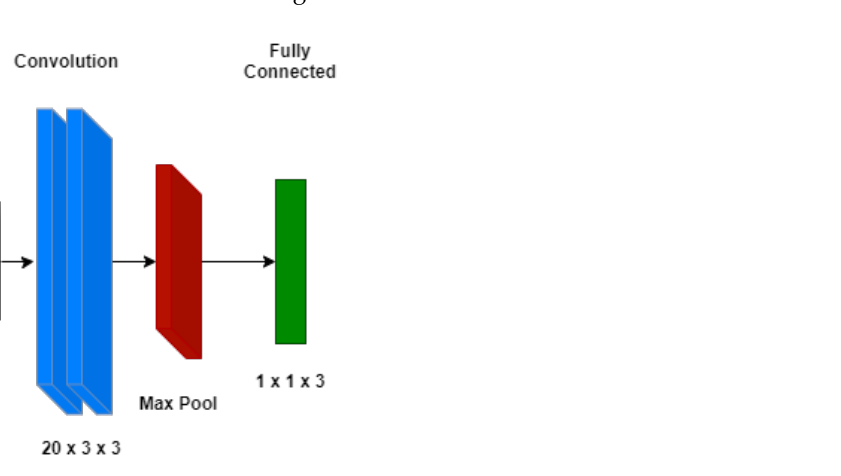
Figure 8. CNN model architecture used in the